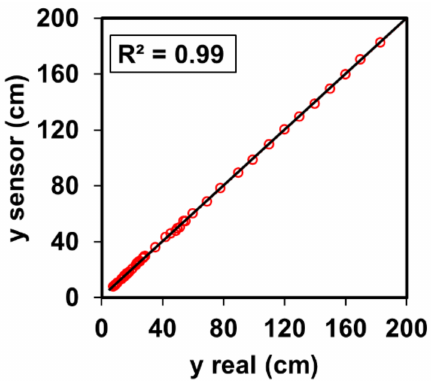
Figure 6. Comparison of sensor measured data and the real measured water